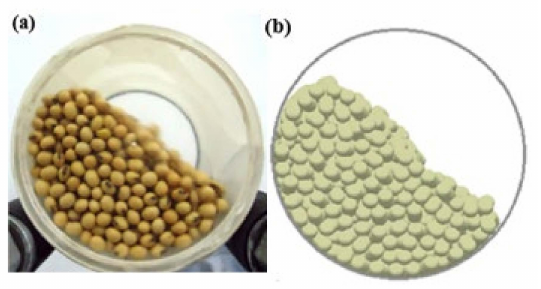
Figure 4. Soybean seed particle dynamic angle of repose. ( a ) Test device diagram; ( b ) simulation